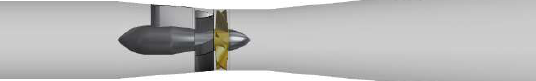
Fig. 1 The hydraulic model of a new turbine